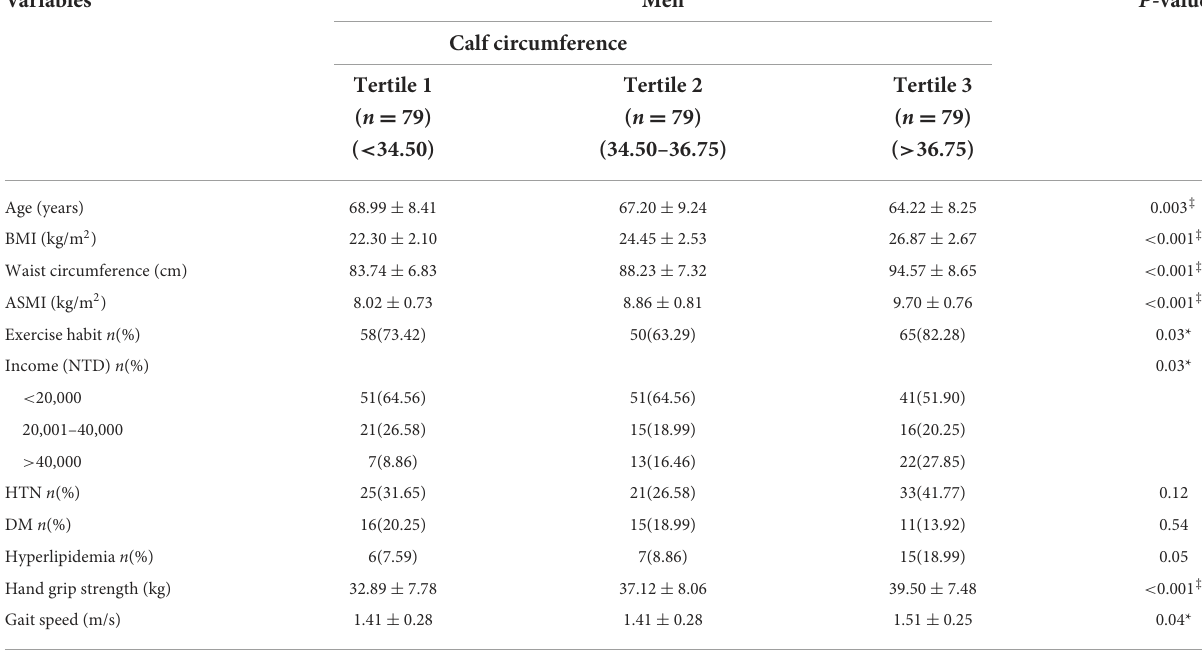
TABLE 2A Baseline characteristics of male participants according to tertile increment of calf